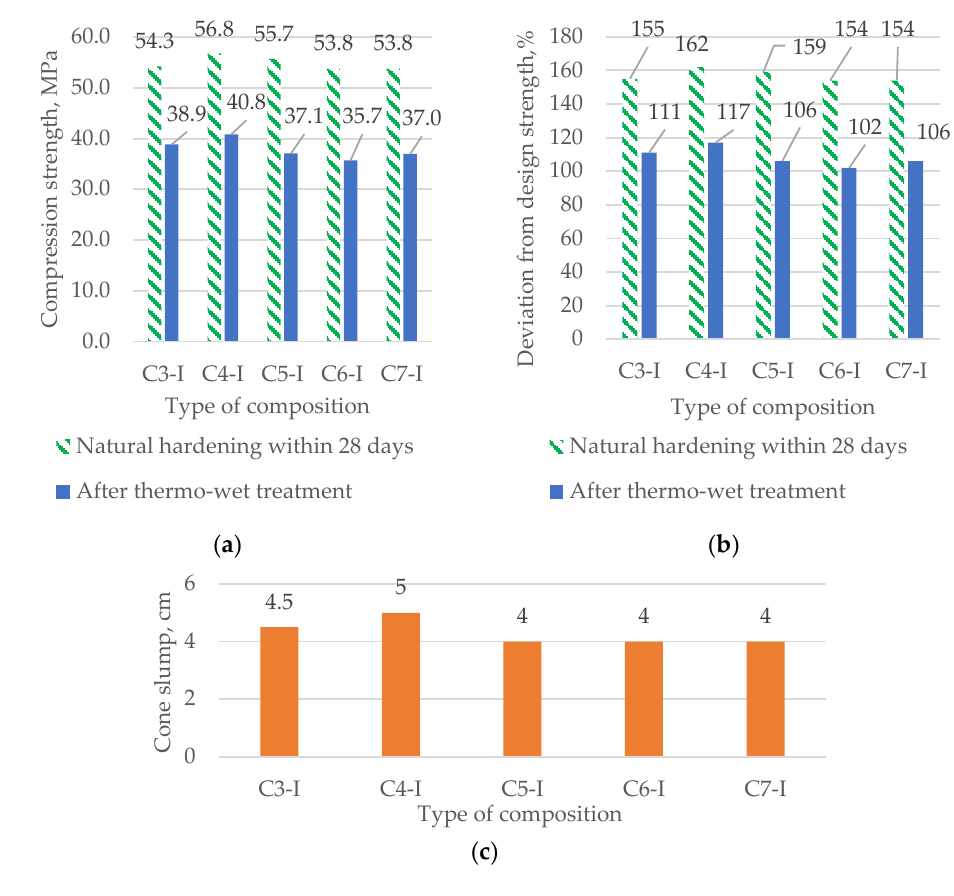
Figure 2. Research results of control compositions and samples of the second stage of the first line of research: ( a ) compressive strength of the samples; ( b ) the deviation of the obtained tensile strength values from the intended strength of 35 MPa; ( c ) concrete slump.